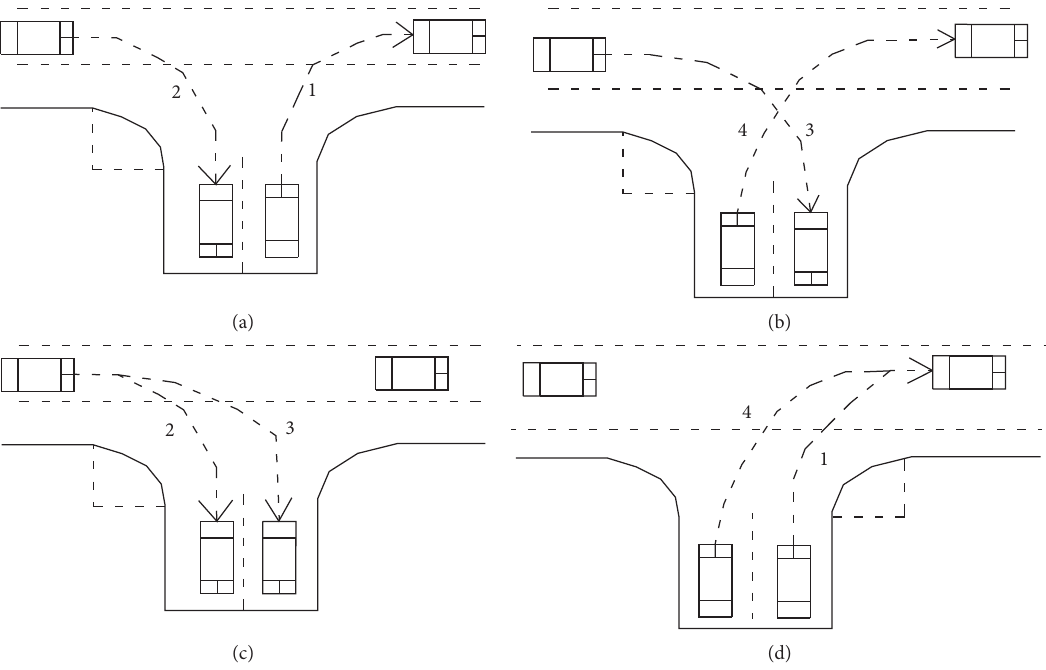
Figure 8: Combinations of right-turning movements. (a) Entering and exiting turns at the near side of the curb. (b) Entering and exiting turns at the far side of the curb. (c) Entering turns at the near and far side of the curb. (d) Exiting turns at the near and far side of the curb.